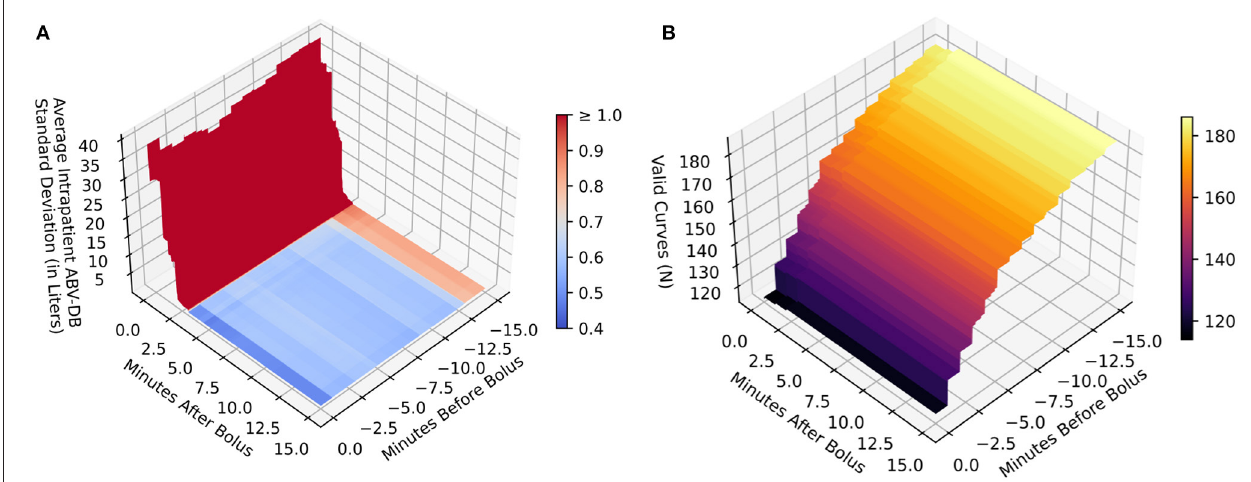
FIGURE 3 | Reproducibility and calculability mapping of all patients with at least two valid measurements (based on 86 patients, 186 sessions). (A) Reproducibility between measurements measured by intra-patient standard deviation of the ABV-DB (vertical axis Z ) by time cut-offs around bolus (horizontal axes X and Y ). (B) Amount of curves usable for ABV-DB calculation (vertical axis Z ) by time cut-offs around bolus (horizontal axes X and Y ). Color bars in (A,B) relate to values on the respective vertical axes Z . This figure maps out the reproducibility and calculability of ABV-DB by the two-point calculation method as previously used by Kron et al. when applying different time interval cut-offs from bolus for the inclusion of data. This serves to find cut-offs that produce robust results on average and do not exclude too many curves, but further methodological considerations should also inform decisions on choosing the correct cut-off intervals. Only data on the RBV curves within the cut-off interval range is used for calculations of the corresponding Z -axis values on these graphs. For the range before bolus, the last measured RBV value before the bolus is used. The reason, why more curves produce usable results with increasing interval size is that in some curves the last measured RBV value is outside the cut-off interval if it is too small. As the interval size is increased, these values become available for analysis and hence the number of valid curves increases. For the range after bolus, the maximum RBV value is used. A reliable RBV maximum for ABV-DB calculation occurs after the dialysate bolus is adequately distributed in the blood stream (at least 2.5min after completion of the bolus injection) and remains robust to further interval increases